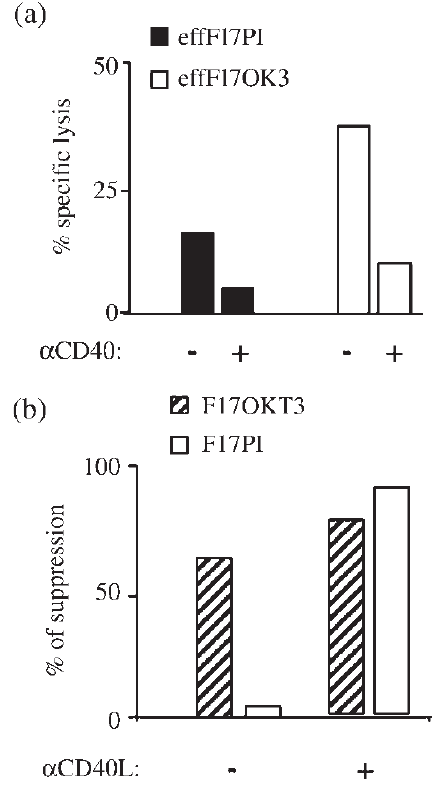
FIGURE 5 CD40/CD40L interaction protects DC from death and treatment of activated T cells with anti-CD40L antagonistic antibody favors suppressive phenomena. (a) Either 9 £ 10 3 effector anergic (effF17OKT3) or PI-activated (effF17PI) F17 cells cultured with 3 £ 10 3 HA307-19-pulsed 51 Cr-labeled DRB1*1101 þ “mature” DC either untreated or treated with a cross-linked anti-CD40 mAb (G28-5) as indicated. The results are expressed as the percentage of specific 51 Cr release and are representative of two experiments. (b) Responder F17 (5 £ 10 3 cells) was cultured with 5 £ 10 3 DRB1*1101 þ “mature” DC pulsed with HA307-19 either alone or in the presence of 1.5 £ 10 4 F17 anergic cells (F17OKT3) or in the presence of 1.5 £ 10 4 PMA þ I stimulated F17 T cells (F17PI) either untreated or treated with the antagonistic anti-CD40L antibody as indicated. Data are reported as in Fig.